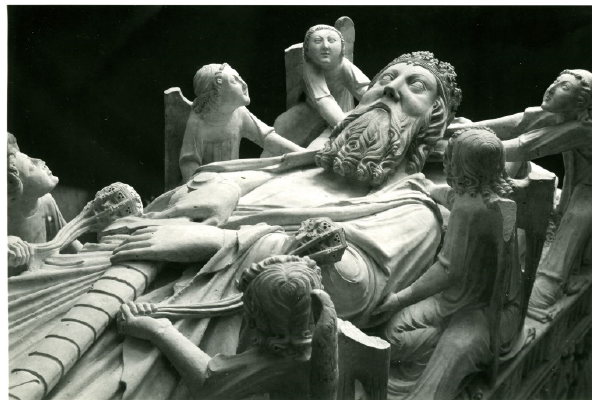
Figure 5. Detail of the lying statue of King Pedro I. Ca. 1357–1361. Alcobaça Monastery Church. Photo: Mário Novais (CRSIQS).